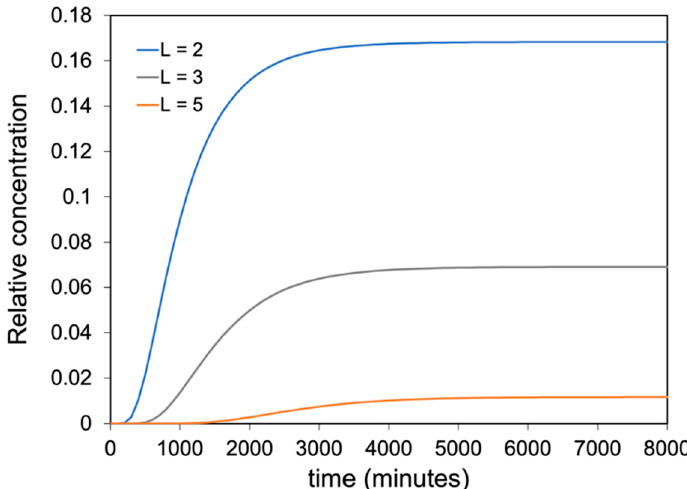
Figure 11. Modelling of breakthrough curve with different filter lengths.